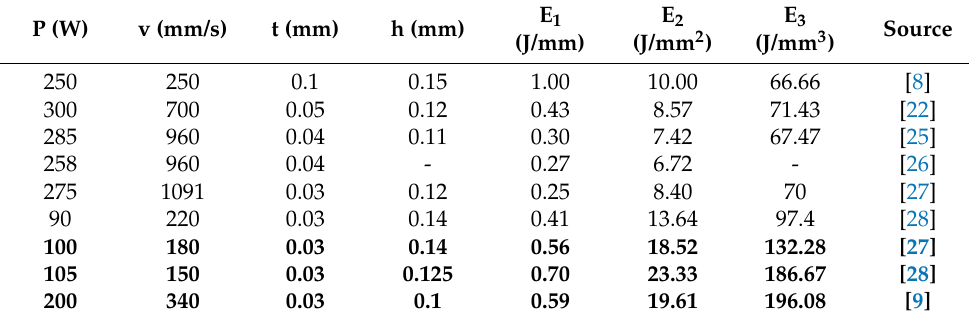
Table 2. Parameters obtained based on the state of the art.